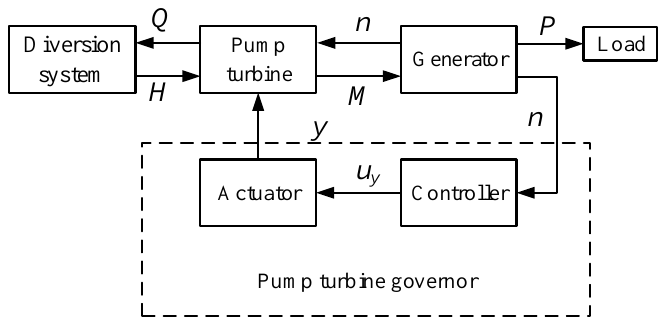
Figure 2. Structure diagram of the PSU speed-regulating system.